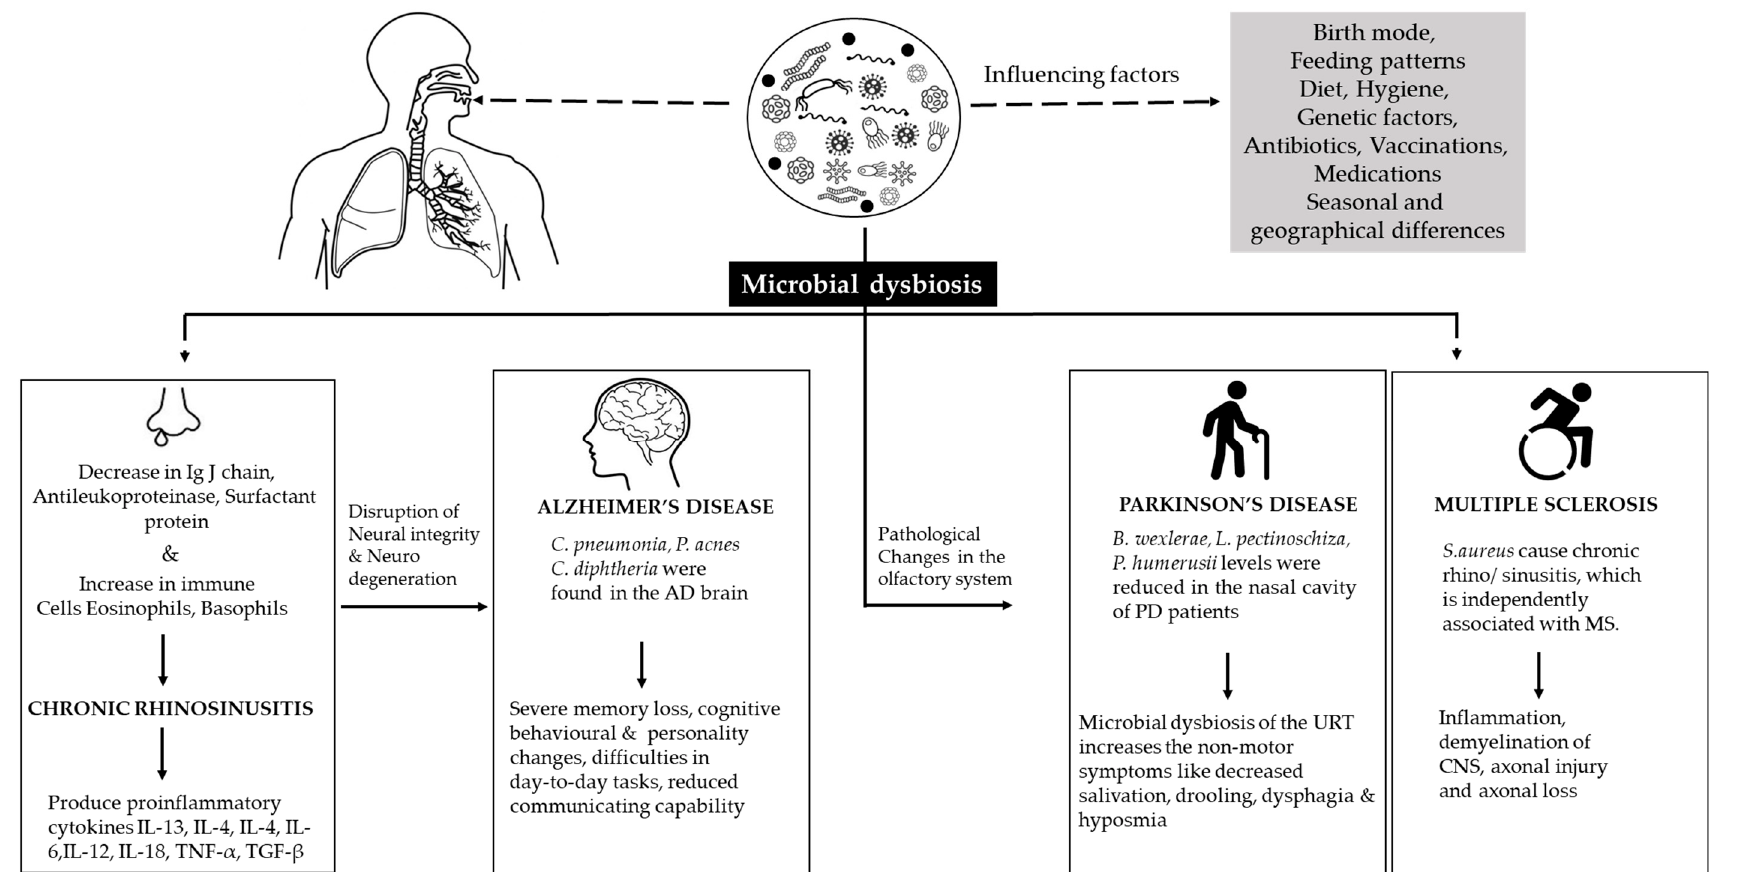
Figure 3. Illustration representing the correlation between nasal microbial dysbiosis and chronic rhinosinusitis (CRS), Alzheimer’s disease (AD), Parkinson’s disease (PD), and multiple sclerosis (MS). C. pneumonia (Chlamydia pneumoniae); P. acnes (Propionibacterium acnes); C. diphtheria (Corynebacterium diphtheriae); B. wexlerae (Blautia wexlerae); L. pectinoschiza (Lachnospira pectinoschiza); P. humerusii (Propionibacterium humerusii); S. aureus (Staphylococcus aureus ).